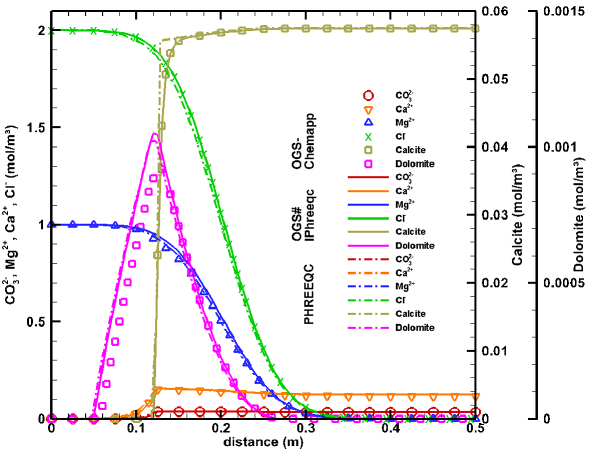
Figure 2. Comparison of calcite and dolomite precipita- tion/dissolution simulation with OGS-ChemApp, OGS#IPhreeqc and